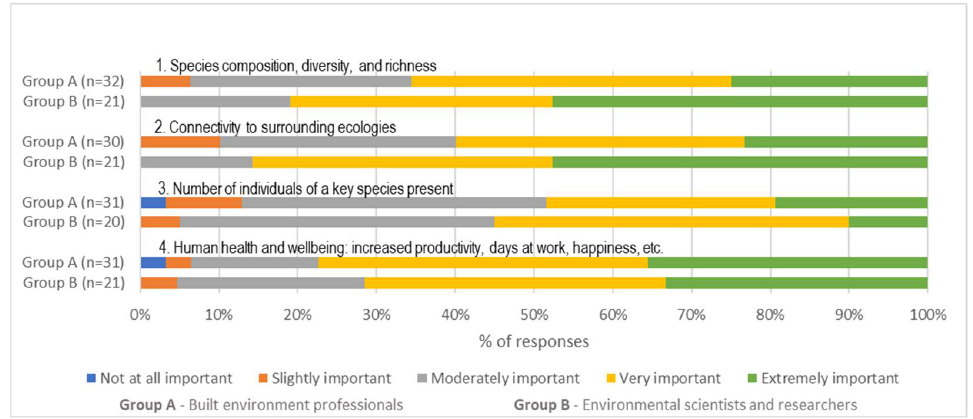
Figure 15. Performance indicators for assessing the success of building-related habitat provisioning strategies post-construction.